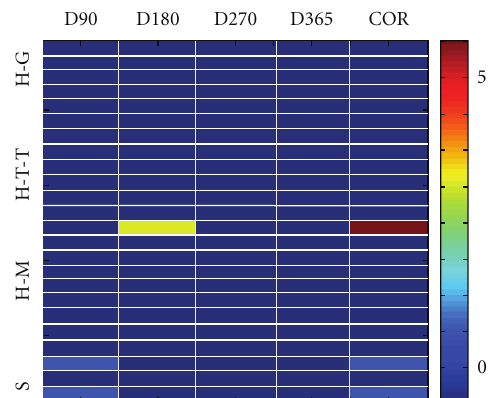
Figure 9: IGF1 treatment is safe and tolerated by patients. Representation of the possible side e ff ects of IGF1 in all of the treated patients: hypoglycemia (H-G), tonsillar hypertrophy (H- T-T), mammary hyperplasia (H-M), and seizures (S) at di ff erent times after IGF1 administration (D90, D180, D270, and D365) and correlation with IGF1 administration in all the treated patients. In the graph is reported the score for all the possible side e ff ects in each subject and the correlation between the symptom and IGF1 administration (colorbar values from 1 to 5). The graph shows that only one patient—between D90 and D180—presented moderate mammary hyperplasia (score 3). This event is highly correlated to the IGF1 treatment (correlation score 5, values on the right) but disappeared spontaneously and without the administration of additional therapy. Two additional patients showed seizures during the treatment (score 1) but these are not associated with IGF1 treatment (correlation score